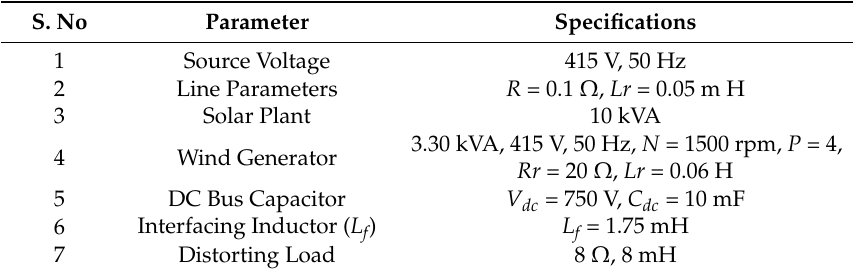
Table 1. System Parameter